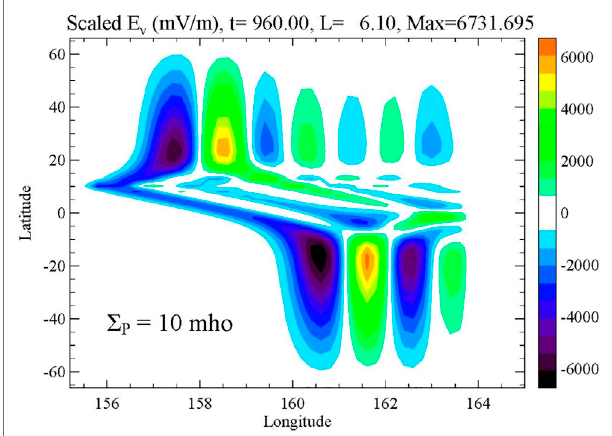
FIGURE 5 | Snapshot of the radial electric fi eld in a simulation of Io ’ s interaction with the Jovian magnetosphere (Lysak et al., 2021b). The location of Io is at the leading spot on the left side of the fi gure. The Alfvén waves generated by the Io interaction are shown. Note that the waves in the dense plasma disk near the equator are propagating more slowly than in the low density lobe region at higher latitudes. The re fl ections at the boundary of the plasma disk can be